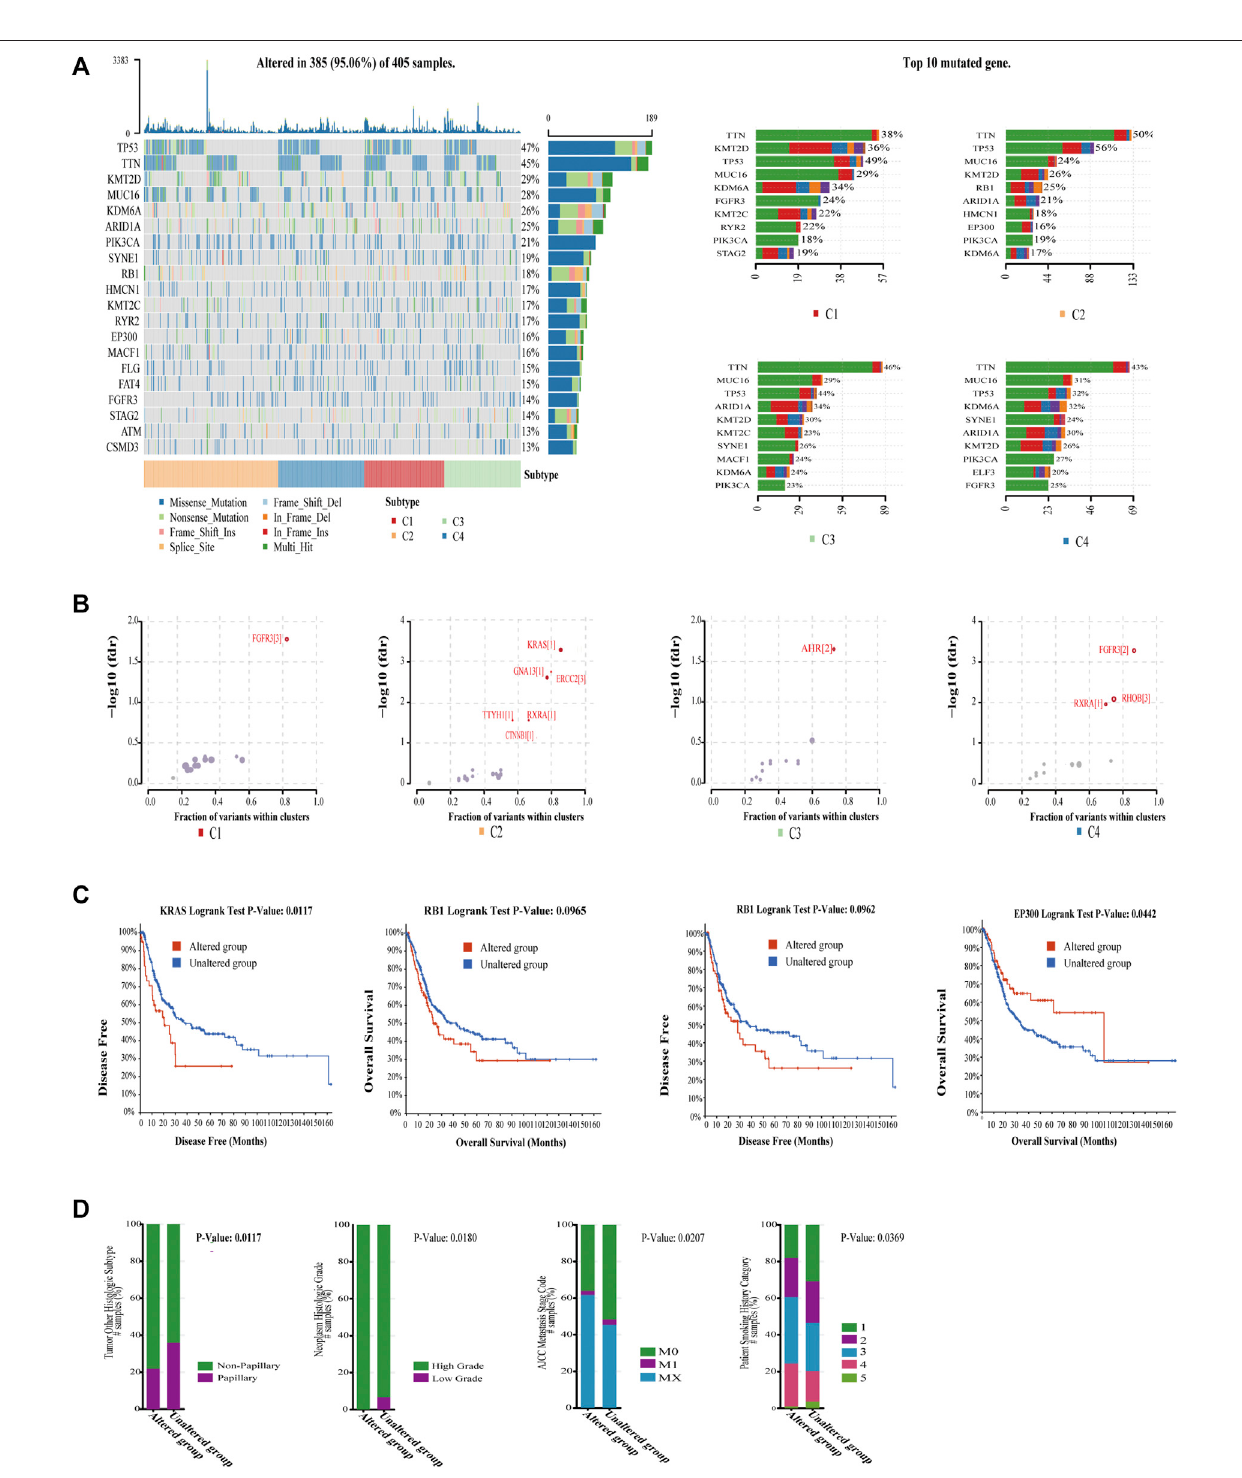
FIGURE 5 | Characterization of genomic driver mechanisms by mutation pro fi les in four subtypes. (A) The vast majority of BC were mutated, and waterfall plots demonstratesigni fi cantdifferencesinthemutationratesofthetop20mutatedgenesintheoverallcohortacrossthefoursubtypesaswellassigni fi cantdifferencesinthe mutationratesoftop10mutatedgenesineachsubtype. (B) Bubbleplotshowsdrivermutationsoffoursubtypes,andC2hadmostofthedrivermutations,whichmostly cause immunosuppression. (C) KRAS, RB1, and EP300 mutations, which are mostly mutated in C2 correlated with worse OS or DFS in TCGA-BLCA cohort. The log-rank test p values are shown. (D) RB1 mutation correlated with bad histologic subtype (chi-squared test, p = .0133), high grade (chi-squared test, p = .0180), high metastasis stage (chi-squared test, p = .0207), and more smoking (chi-squared test, p = .0369).